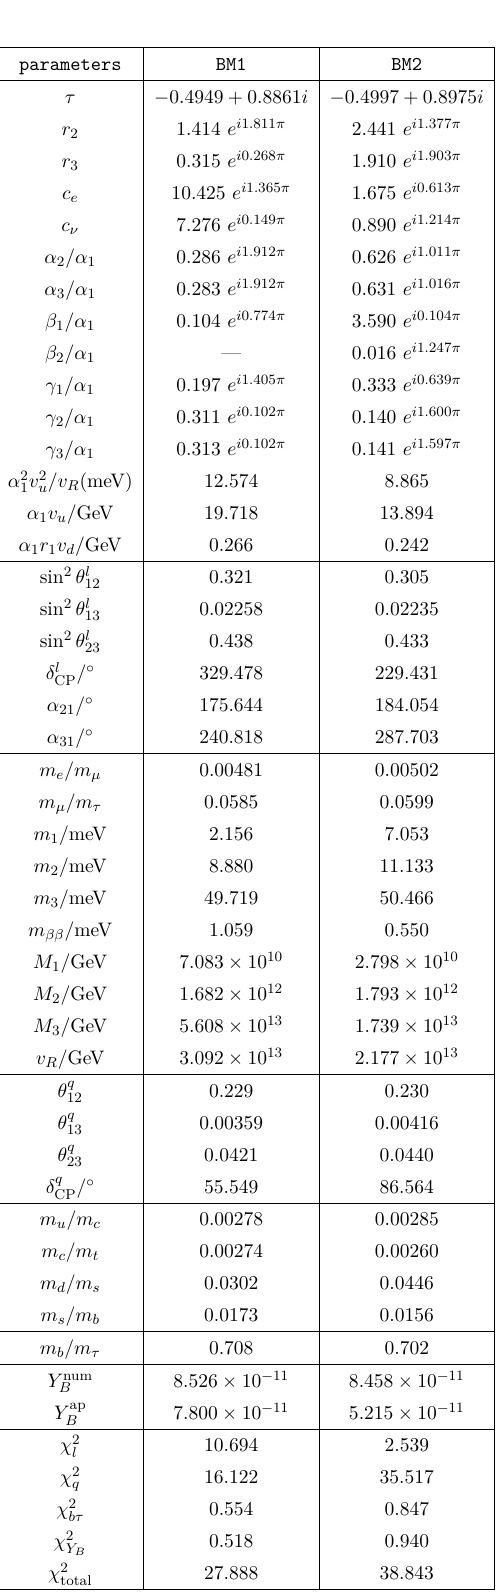
Table 4 . Similar to table 3, but for thermal initial abundance of the right-handed